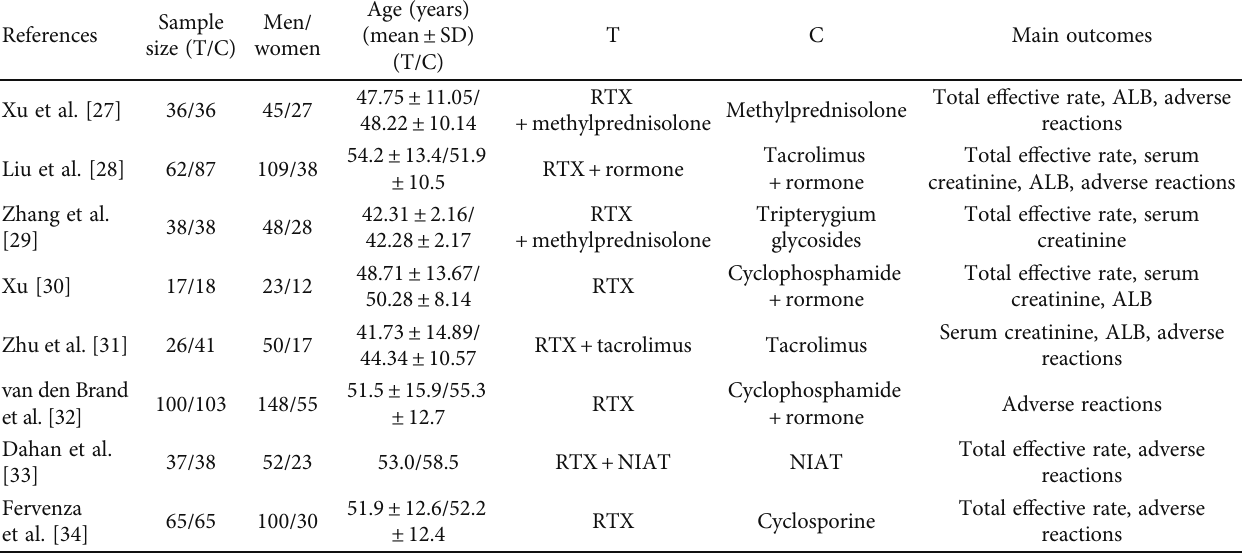
Table 1: Basic characteristics of the included